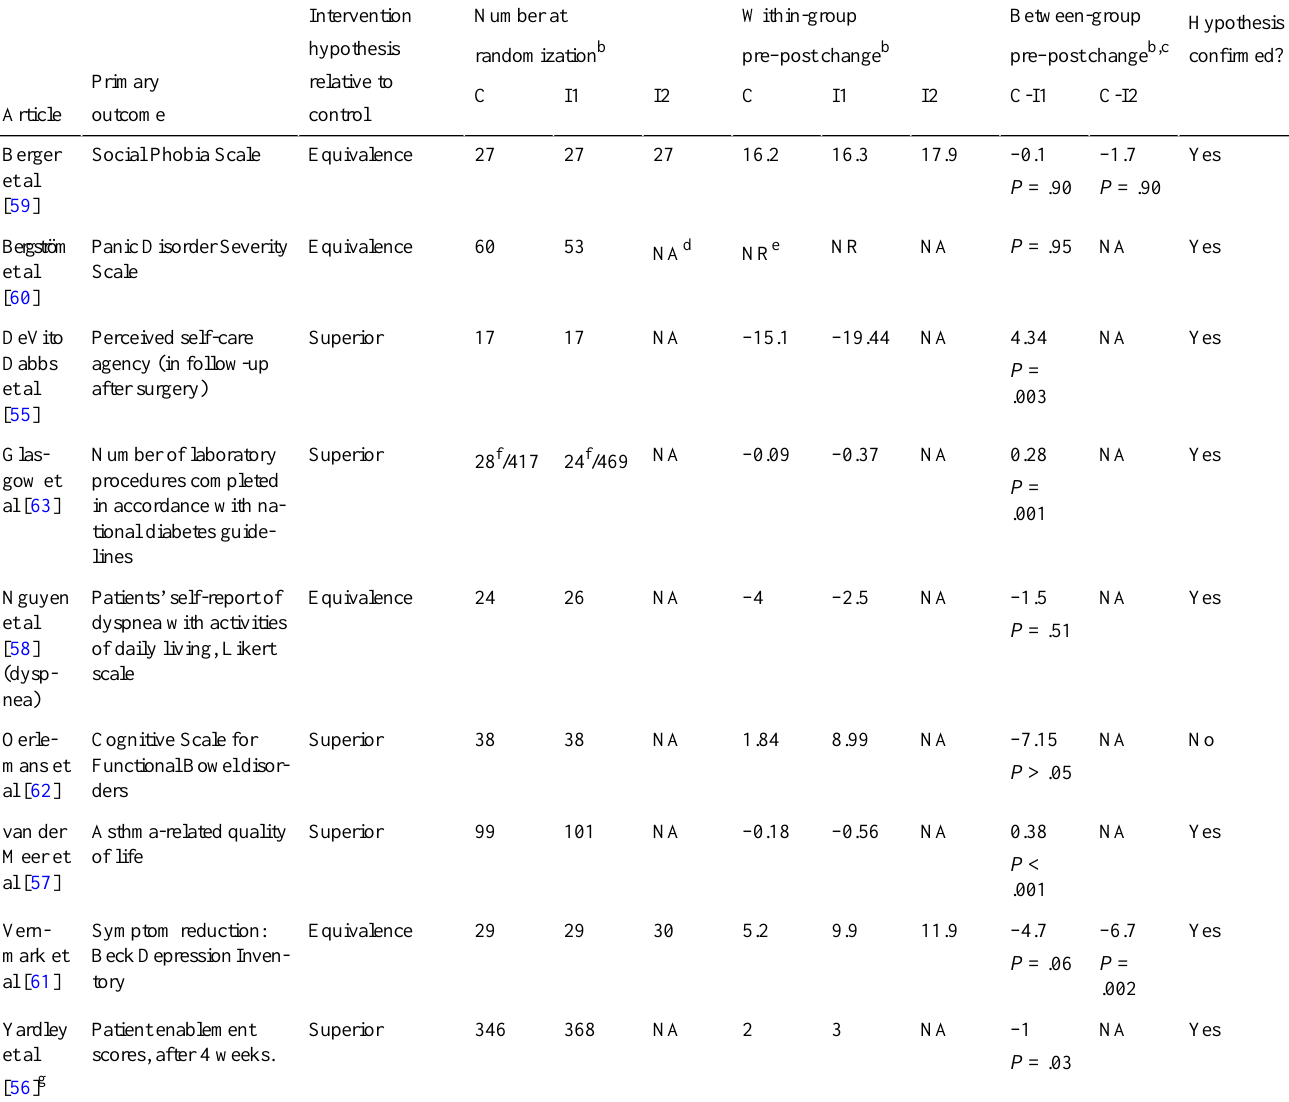
Table 4. Effects reported in self-management with clinical support randomized controlled trials of acceptable quality of electronic symptom reporting, in alphabetic order of first author a